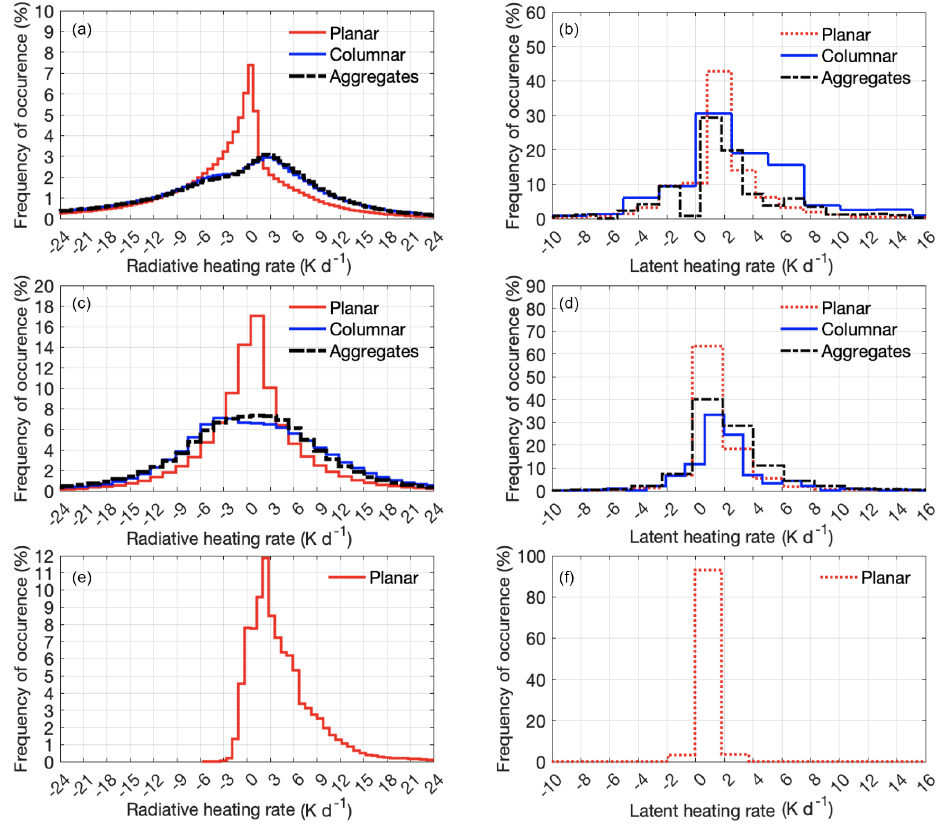
Figure 19. Histograms of diabatic heating in the TTL from microphysics (b, d, f) and radiation (a, c, e) in the deep-convection (a, b) , thick-anvil (c, d) , and thin-cirrus (e, f) regions for different ice habits, i.e., columnar (blue) planar (red), and aggregate